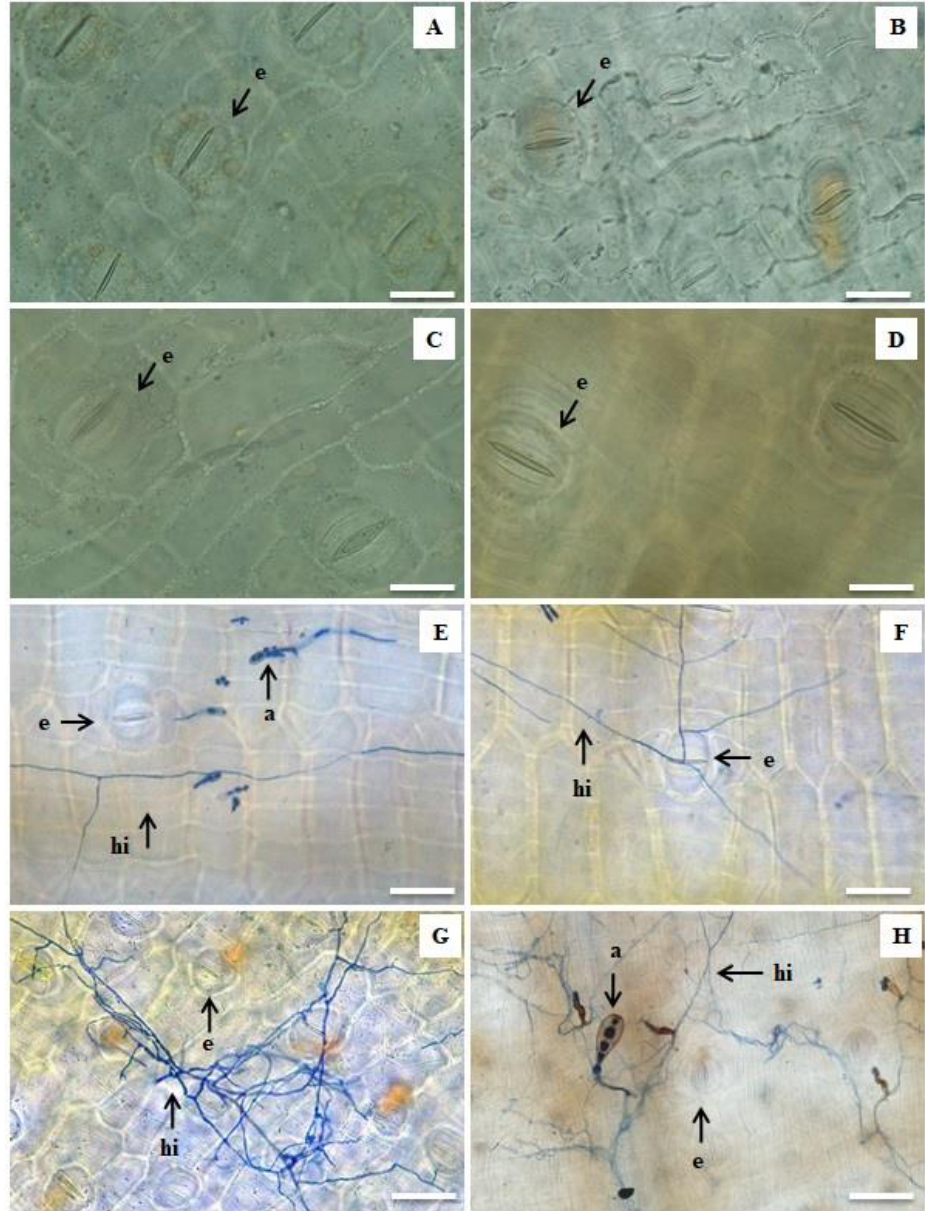
Figure 4. Clarification and staining of fungal structures in banana leaves. Non-inoculated treatments: Calcutta 4 ( A ), Krasan Saichon ( B ), Grand Naine ( C ) and Akondro Mainty ( D ). Treatments after inoculation (21 DAI) with P. fijiensis isolate: Calcutta 4 ( E ), Krasan Saichon ( F ), Grand Naine ( G ) and Akondro Mainty ( H ). a = ascospores; hi = hyphae; e = stomata. White bar ( A – D ): 50 μm; White bar ( E – H ): 200 μm.